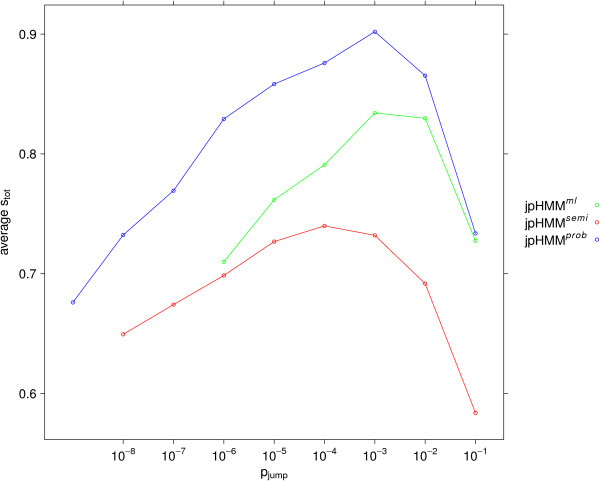
The performance of different versions of jpHMM onTrec. The performance of jpHMM ml, jpHMM semi, and jpHMM prob on Trec for different choices of pjump is shown. It is measured by stot.